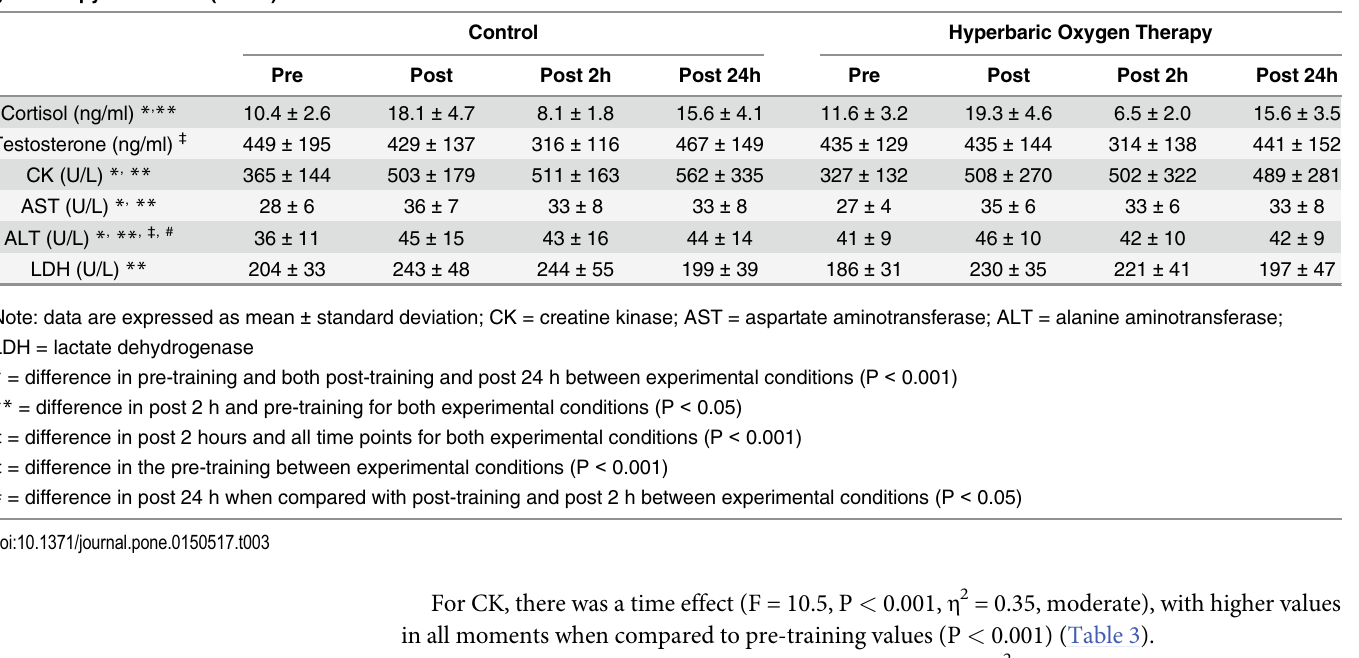
Table 3. Hormonal responses and cellular damage prior to and following training in Brazilian jiu-jitsu athletes for the control and hyperbaric oxy- gen therapy conditions (n =